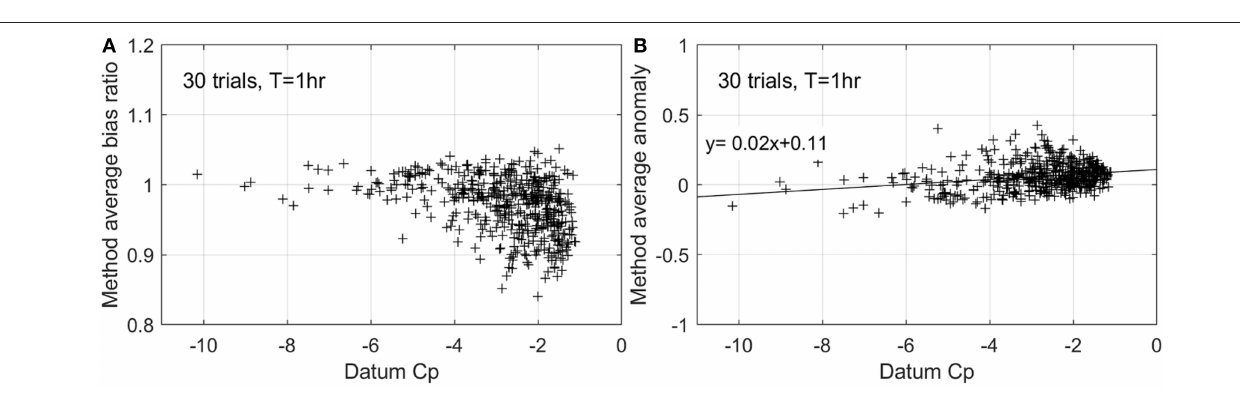
FIGURE 10 | XIMIS bias and average anomaly vs. datum design value for T = 1h records ( N peak = 30): (A) bias (method/datum), (B) anomaly